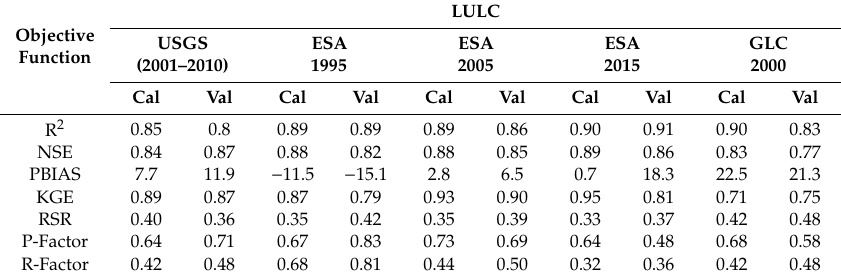
Table 2. Objective function values with observed rainfall using LULC USGS-(2001–2010), European Space Agency (ESA) (1995, 2005, 2015), and global land cover (GLC)-2000 China data for the Qianjiang Hydrological Station.